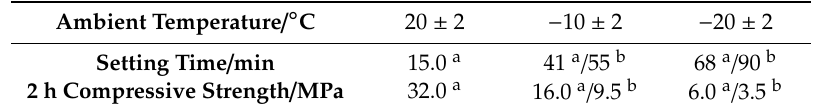
Table 2. Early-age performance of magnesium phosphate cement (MPC) prepared and cured at di ff erent temperatures.